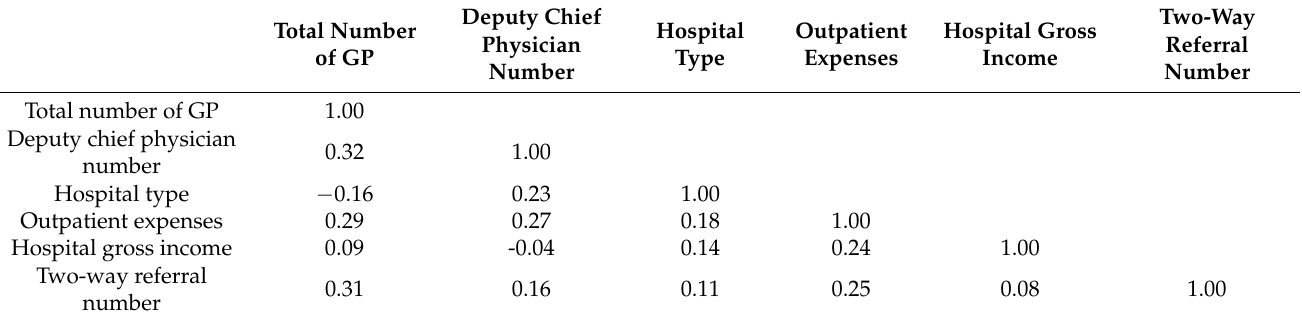
Table 7. Correlation